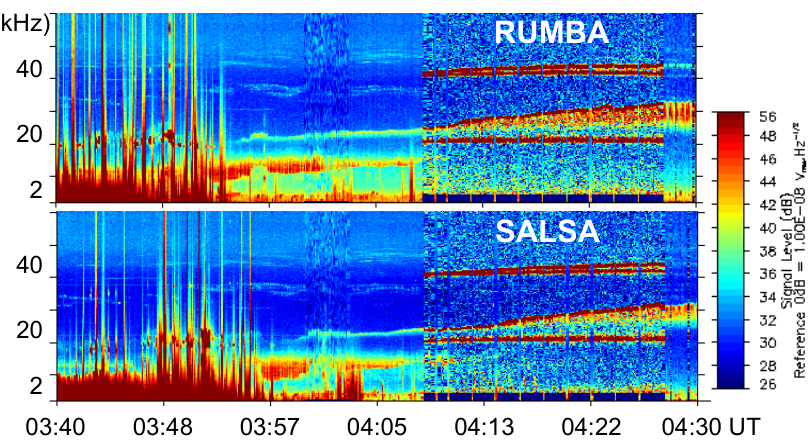
Fig. 5. Comparison of RUMBA and SALSA frequency/time spectrograms, illustrating several properties of the wave emissions in the internal magnetosphere on 6 October 2000 (9.5MLT, − 75 ◦ invariant latitude, 4 . 3 R E